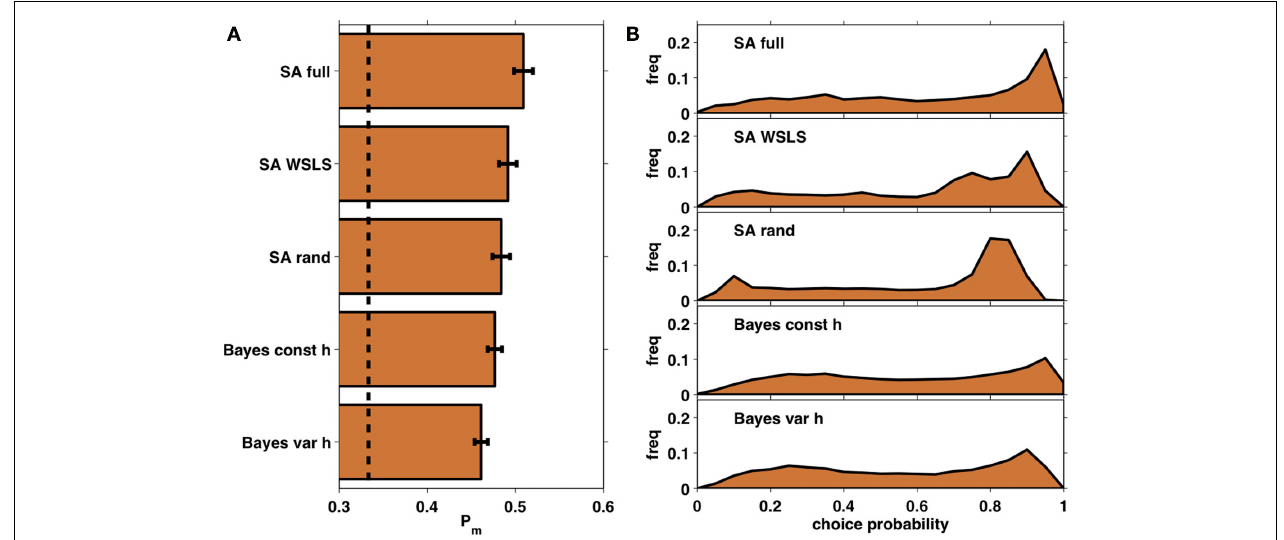
FIGURE 7 | (A) Average choice probabilities, P m , for each of the five models averaged across subjects. Dashed line: chance; error bars: SEM. (B) Histograms of choice probabilities for the five different models using data from all 35 subjects.